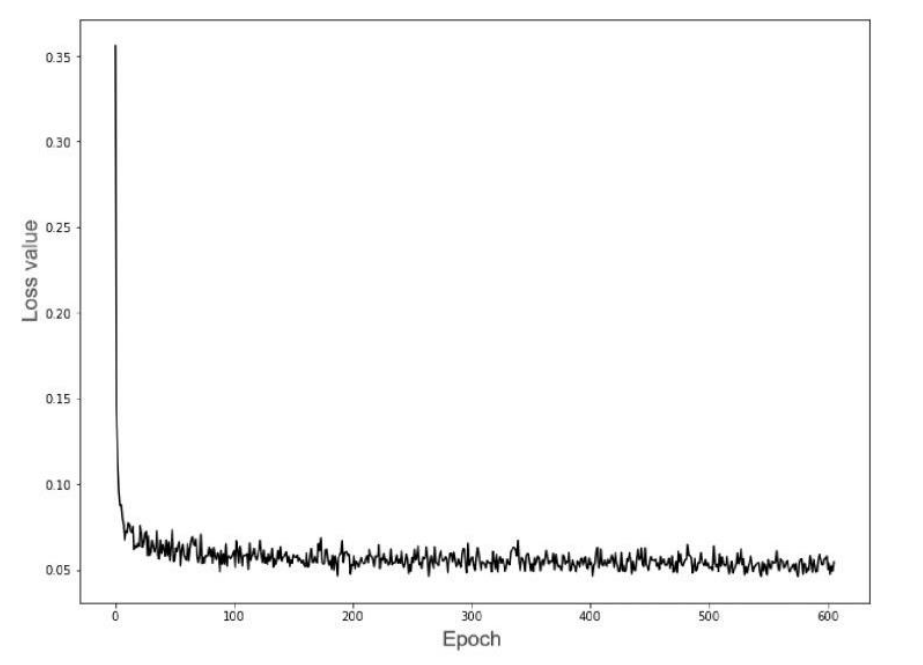
Figure 10. A loss function graph of the training set.